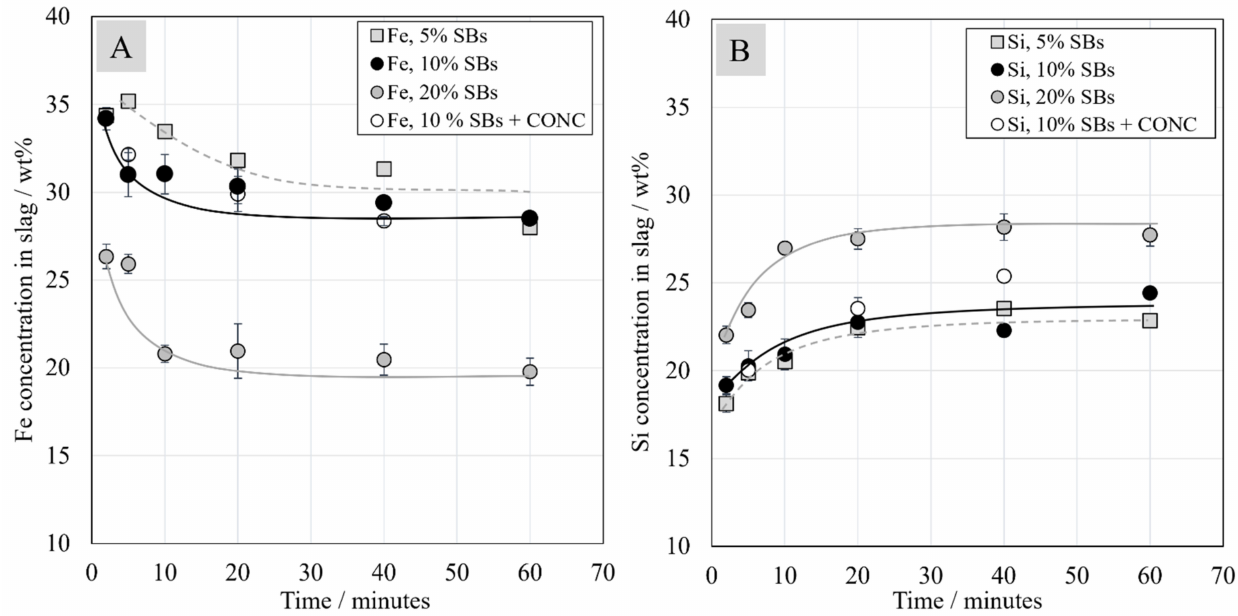
Figure 4. Chemical concentrations of Fe ( A ) and Si ( B ) in the slag as a function of contact time at 1350 ◦